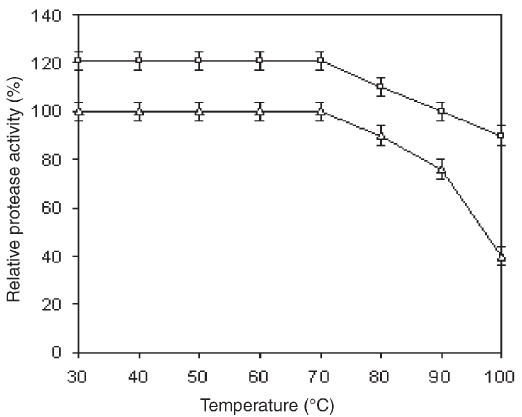
Figure 4. Effect of temperature on the stability of purified protease. The enzyme in glycine-NaOH buffer (pH 10.0) with 100 mM Ca 2+ ( (cid:2) ) and without 100 mM Ca 2+ ( (cid:4) ) was preincubated for 1 h at the specified temperatures.The residualenzymaticactivity was measured under the standardconditions.Each value representsthe mean ± SE of three independent